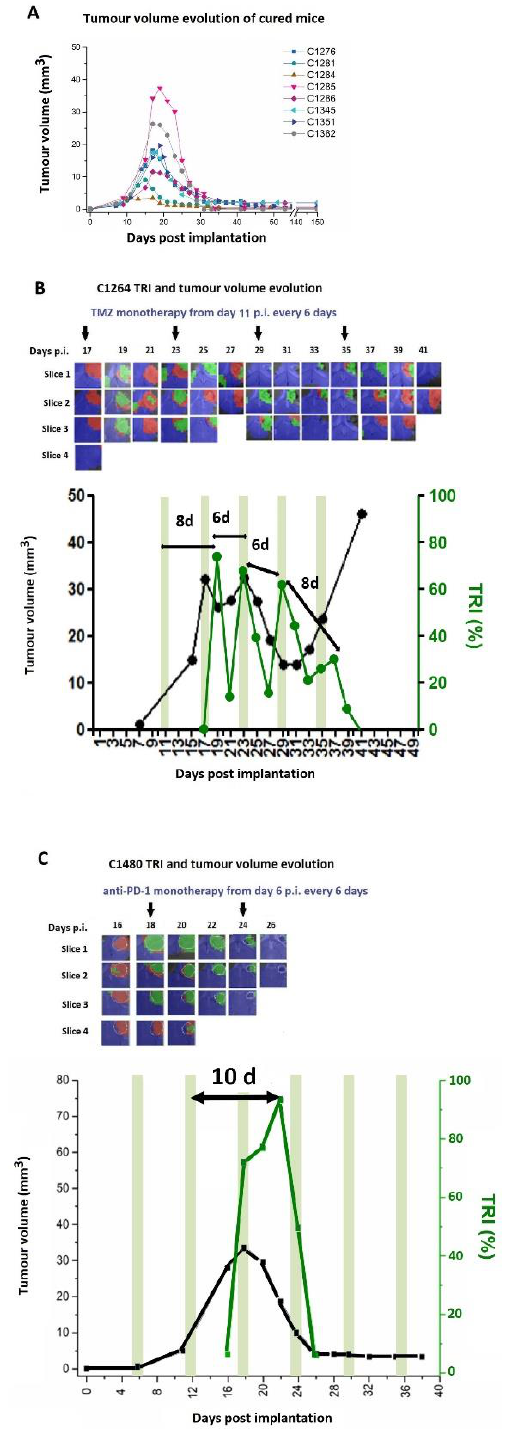
Figure 2. ( A ) Tumor volume evolution of GL261 tumor-bearing mice declared cured from an Immune-Enhancing Metronomic Schedule (IMS)-TMZ treated group ( n = 8), described by us in [57], consisting of an every-6-day administration. Joint graphical representation of MRSI-based nosolog- ical images and tumor volume evolution for ( B ) case C1264, treated with IMS-TMZ and ( C ) case C1480, treated with anti-PD-1 immunotherapy in IMS protocol. Tumor volume in mm 3 (black line, left axis) and the percentage of responding pixels (TRI, green line, right axis). See Section 2.1 and the Supplementary Materials for a description of the TRI calculation. Green-shaded columns indi- cate therapy administration days (TMZ and anti-PD-1 immunotherapy respectively). TRI cycle du- ration (i.e., therapy administration to next peak maxima) is highlighted in every image. In the upper part of the images, the evolution of the nosological images is shown superimposed onto the T2w- MRI for each slice for chosen timepoints. Vertical black arrows indicate days of therapy